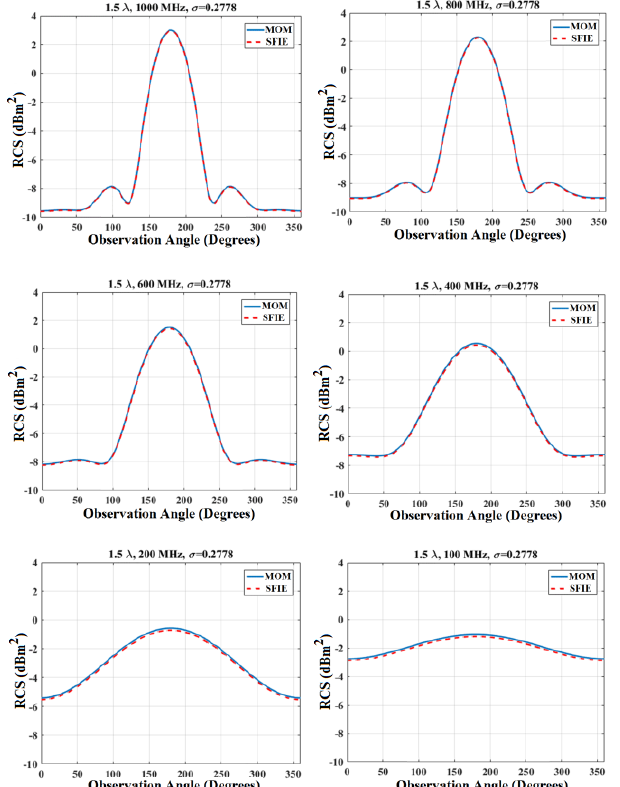
Figure 14: Comparison of RCS curves found by SFIE and MoM for r=1.5 λ and 𝜎 =0.2778 as frequency decreases